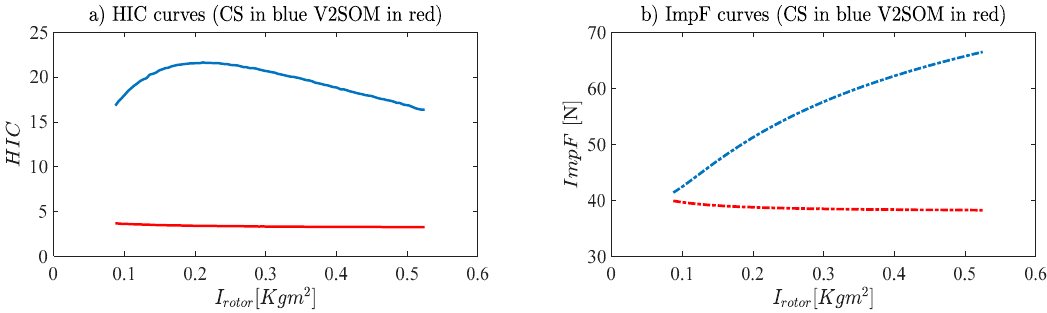
Figure 12. I rotor impact on safety criteria, ( a ) HIC and ( b ) ImpF, for both V2SOM and CS characteristics.